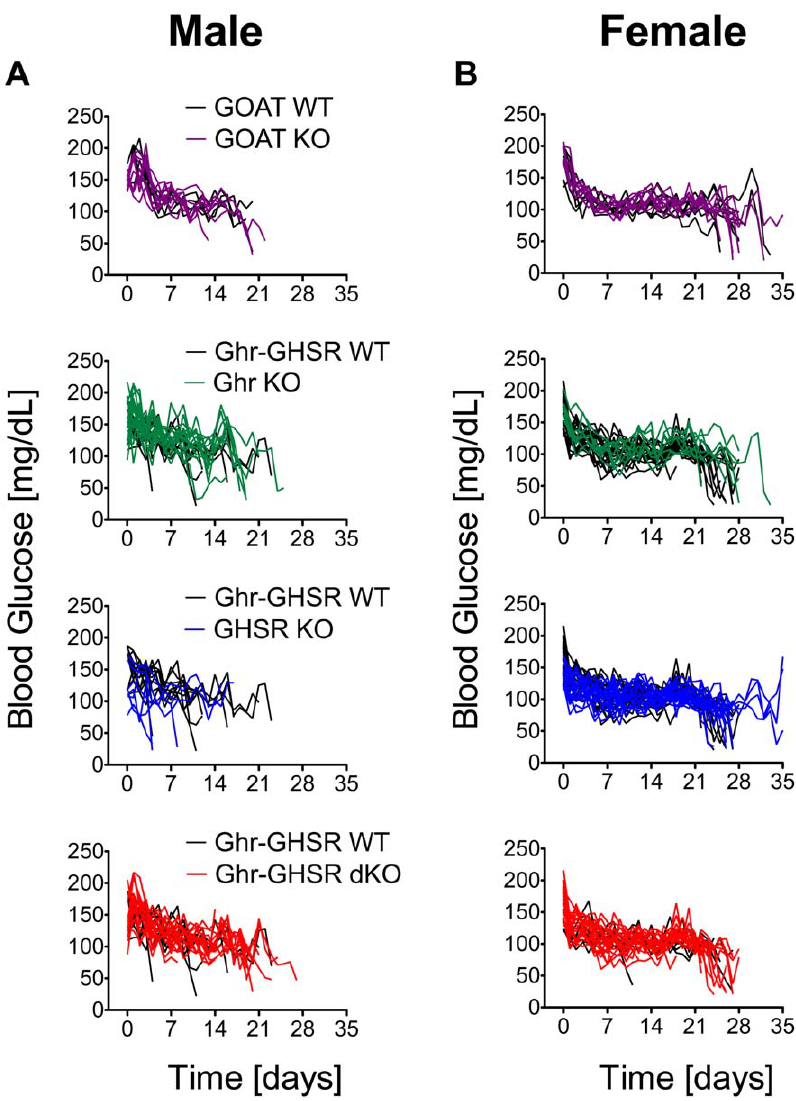
Figure 2. Effects of chronic CR on blood glucose levels. Chronic CR (40% of ad libitum calories) decreased glucose levels in male (A) and female (B) wildtype (WT) and GOAT, Ghrelin (Ghr), GHSR, or Ghr-GHSR dKO mice. However, ghrelin loss-of function did not increase the risk for hypoglycemia, compared to the respective WT mice. Values are shown for each individual animal. Mice were taken out of the CR regiment when either fat mass dropped to 0% for 2 consecutive days, or when mice became hypoglycemic. Lines depict glucose levels for individual animals from groups of 8 male GOAT WT, 5 female GOAT WT, 9 male GOAT KO, 8 female GOAT KO, 10 male Ghr-GHSR dWT, 20 female Ghr-GHSR dWT, 19 male Ghr KO, 18 female Ghr KO, 7 male GHSR KO, 19 female GHSR KO, 16 male Ghr-GHSR dKO and 7 female Ghr-GHSR dKO mice.